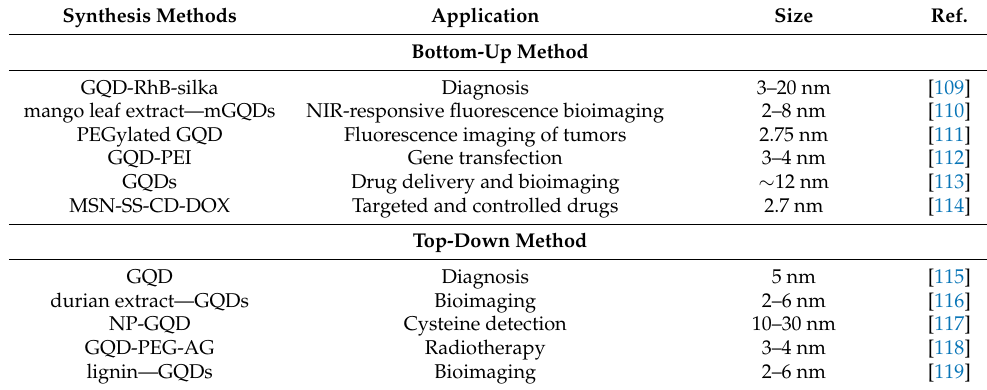
Table 1. Different methods for synthesizing bioactive GQDs are used in biomedical applications.